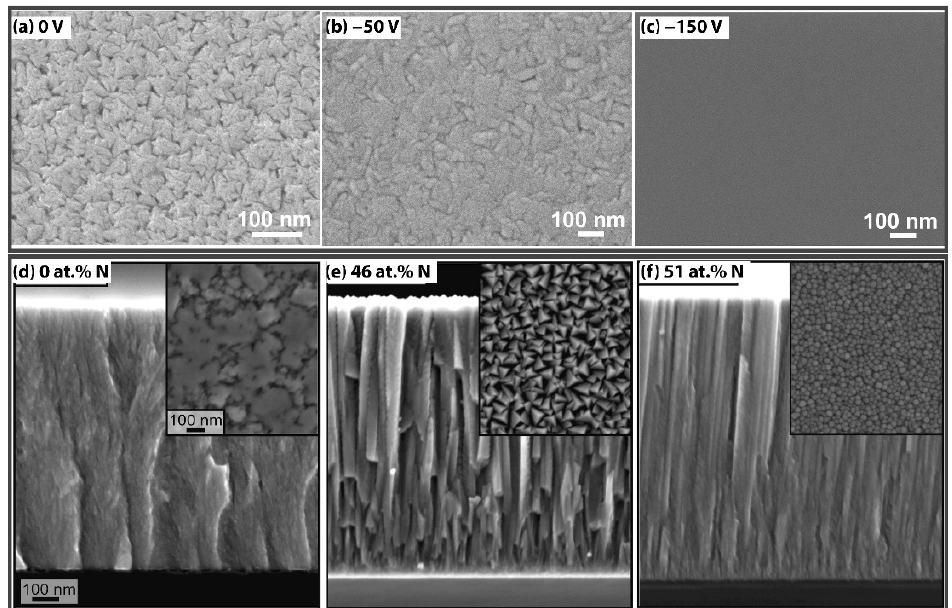
(Figure 4f). On the other hand, nanoparticles with different geometries as a function of nitrogen content were reported for the film FeCoNiCuVZrAl [68]. Without nitrogen, the nanoparticles had a size of about 10 − 25 nm, and the surface became smooth by increasing the nitrogen content.